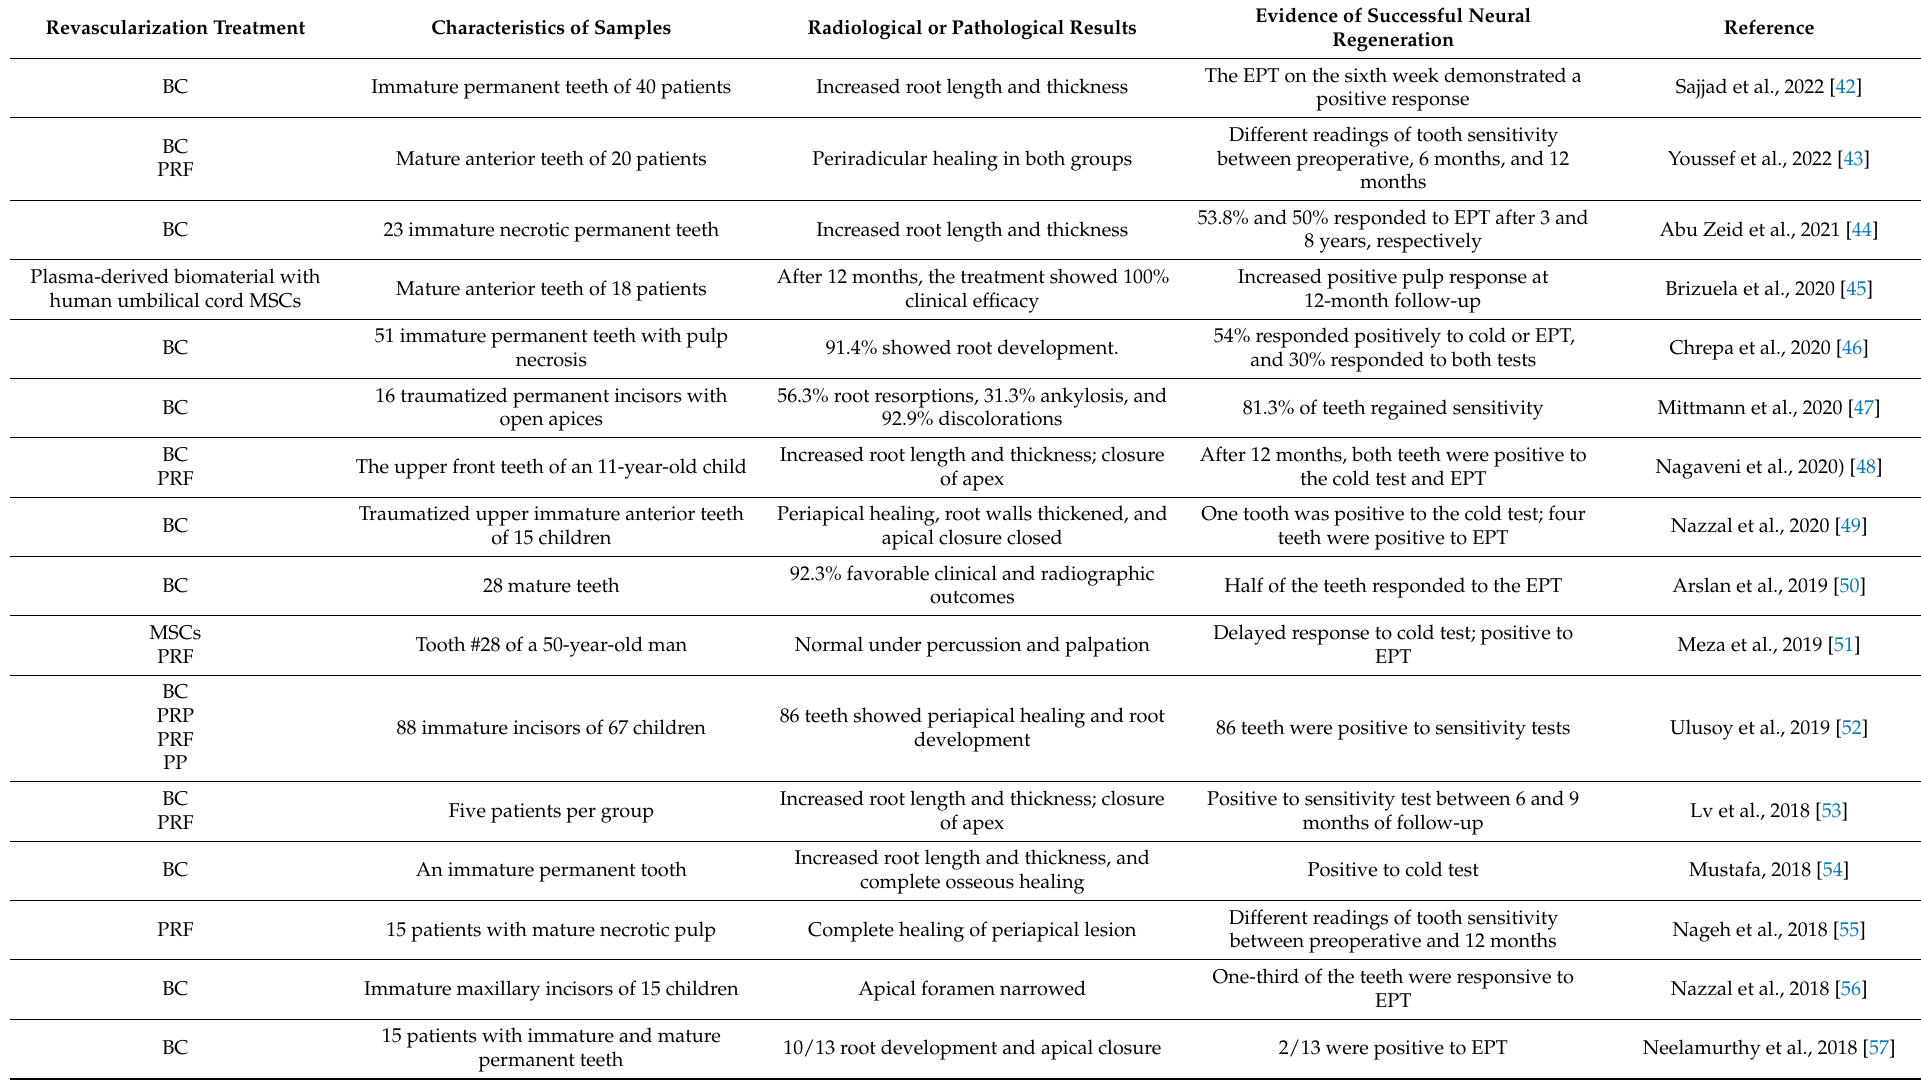
Table 2. Summary of the characteristics of neural regeneration in clinical